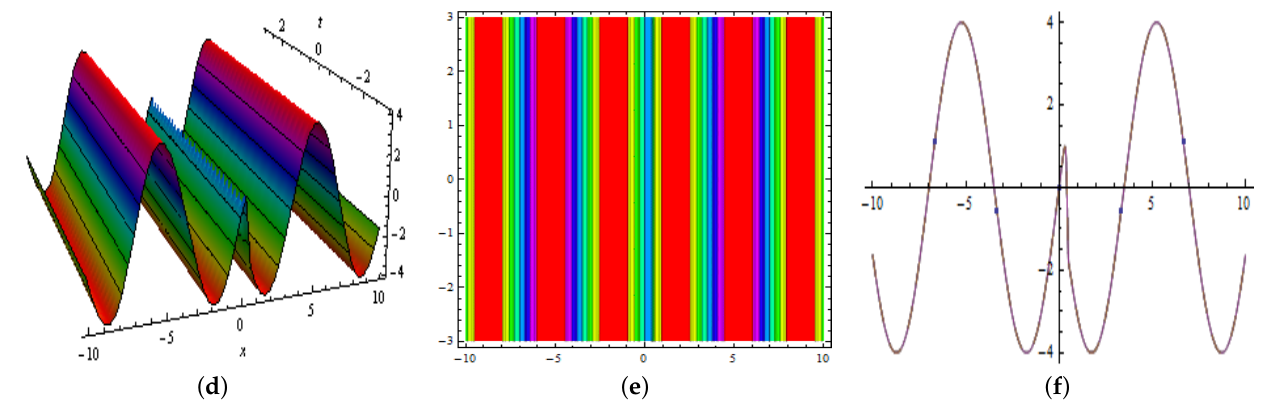
Figure 14. Explain three-dimensions in ( a ); contour in ( b ) and two-dimensions in ( c ), Graphical representation of m 51 ( x , t ) in Equation (54), at b 2 = − 4, b 4 = − 7, b 5 = 10,